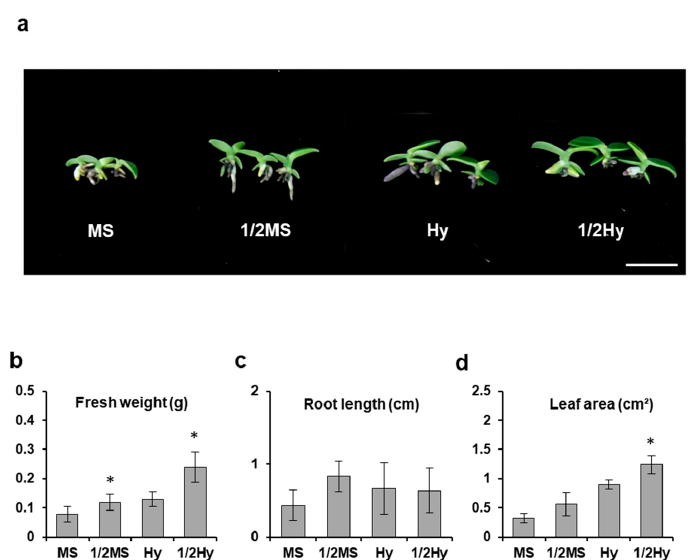
Figure 2. Effects of culture media strength on Sedirea japonica seedling growth. ( a ) Growth differences in seedlings were determined seven months after sowing. The pictures show a representative seedling of each medium. Fresh weight ( b ), root length ( c ), and leaf area ( d ) were measured. Scale bar = 2 cm. MS: full-strength MS; 1/2MS: half-strength MS; Hy: full-strength Hyponex; 1/2Hy: half-strength Hyponex. Data are shown as mean ± SD of the values obtained from triplicate experiments. * p ≤ 0.05.